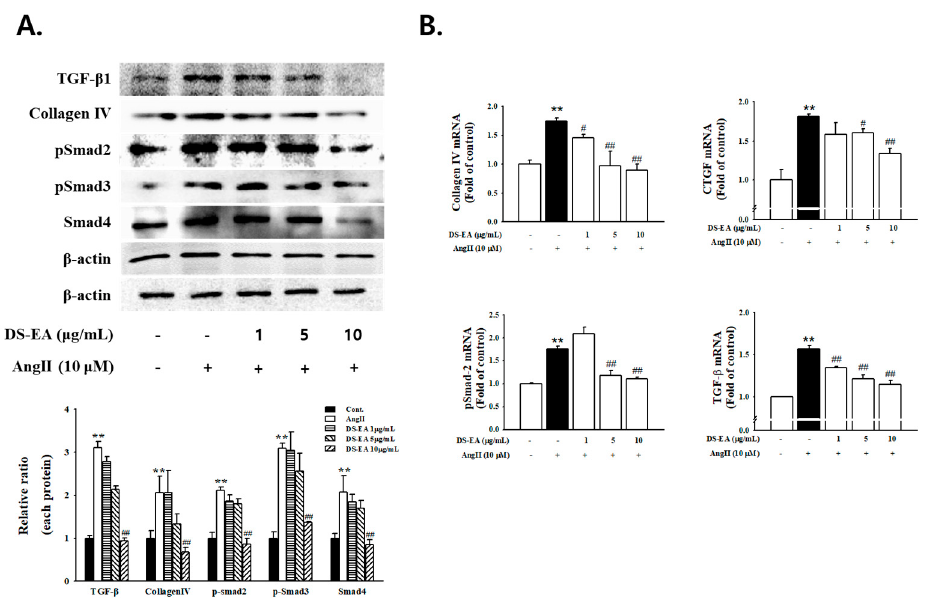
Figure 8. Effect of DS-EA on glomerular fibrosis in human renal mesangial cells. ( A ) Cell lysates were used for western blot analysis with a primary antibody against TGF- β 1, collagen IV, pSmad-2, pSmad-3, and Smad-4. The protein bands were detected by western blotting, and β -actin was used as the internal standard in each sample. ( B ) Real-time PCR showing mRNA levels in DS-EA-treated and Ang II-stimulated mesangial cells. Each value represents the mean ± S.E. of five independent experiments. ** p < 0.01 vs. control; # p < 0.05, ## p < 0.01 vs. Ang II alone.